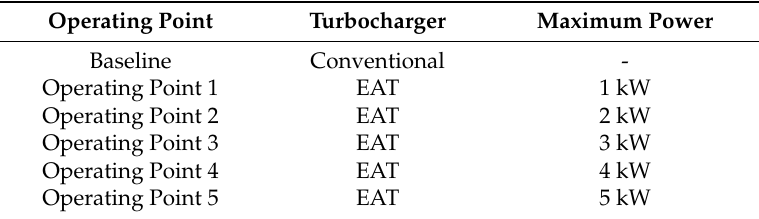
Table 8. The operating points that were used for the simulation.